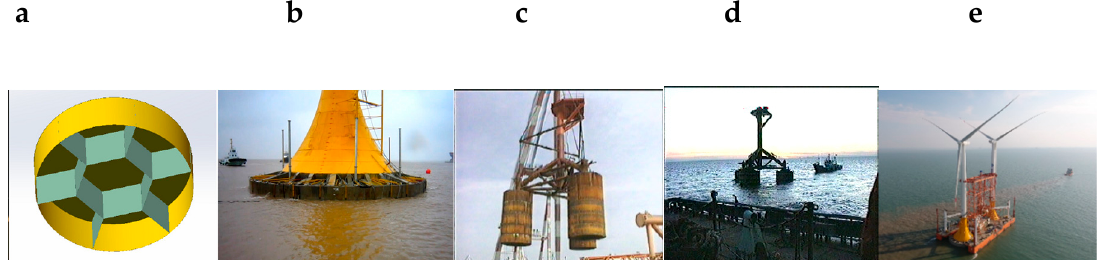
Figure 2. Transportation of bucket foundation: ( a ) mono-bucket with seven rooms as air cushions; ( b ) self-floating towing; ( c ) multi-bucket foundation; ( d ) air-floating towing; ( e ) one-step transportation and installation